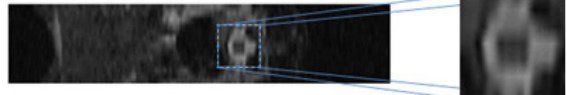
Figure 7. Transverse view of an image T2. Source: Hospital